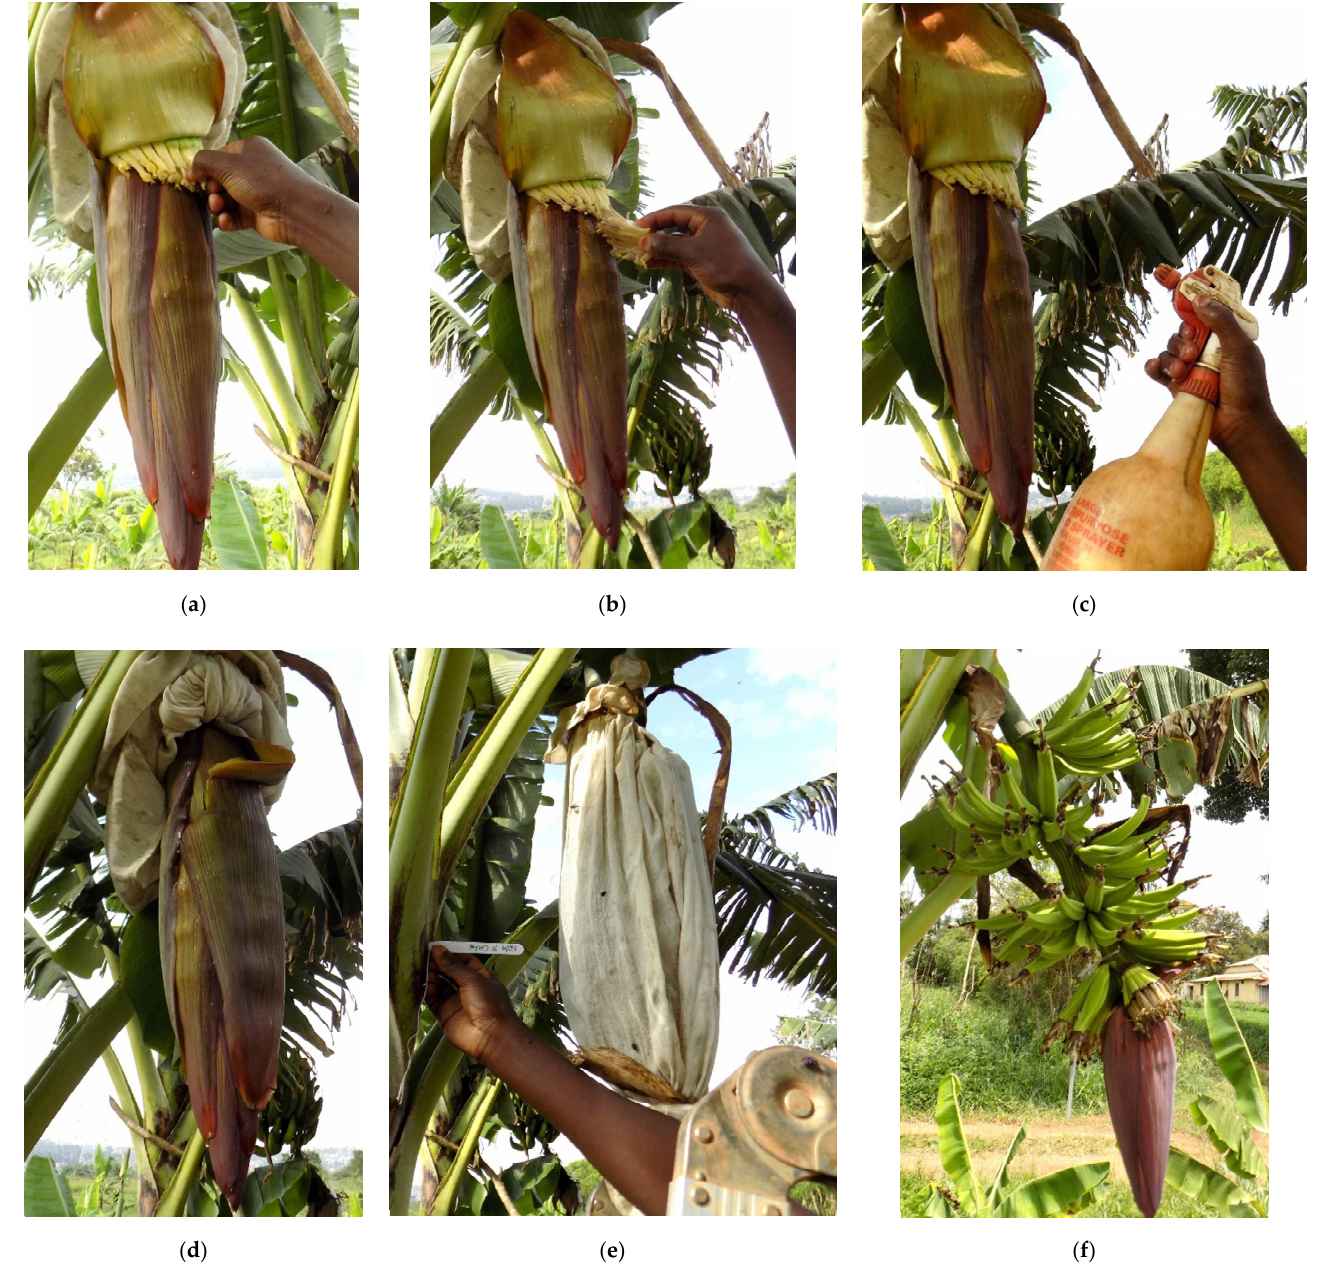
Figure 1. Procedure of early pollination (technique 3) on Musa (AA group subgroup Mchare) “Nshonowa”: ( a ) flower bract forced open and tepals removed to expose stigmas for pollination; ( b ) an excised hand of male flowers rubbed on stigmas to apply pollen; ( c ) pollen germination media (PGM) solution applied with hand sprayer; ( d ) flower bract returned in position; ( e ) inflorescence re-bagged and labeled with names of parents, cross ID, and initial date of pollination. Except labeling, steps from A to E are repeated for pollination of next hand when it is ready; and ( f ) pollinated bunch left to mature in the open.